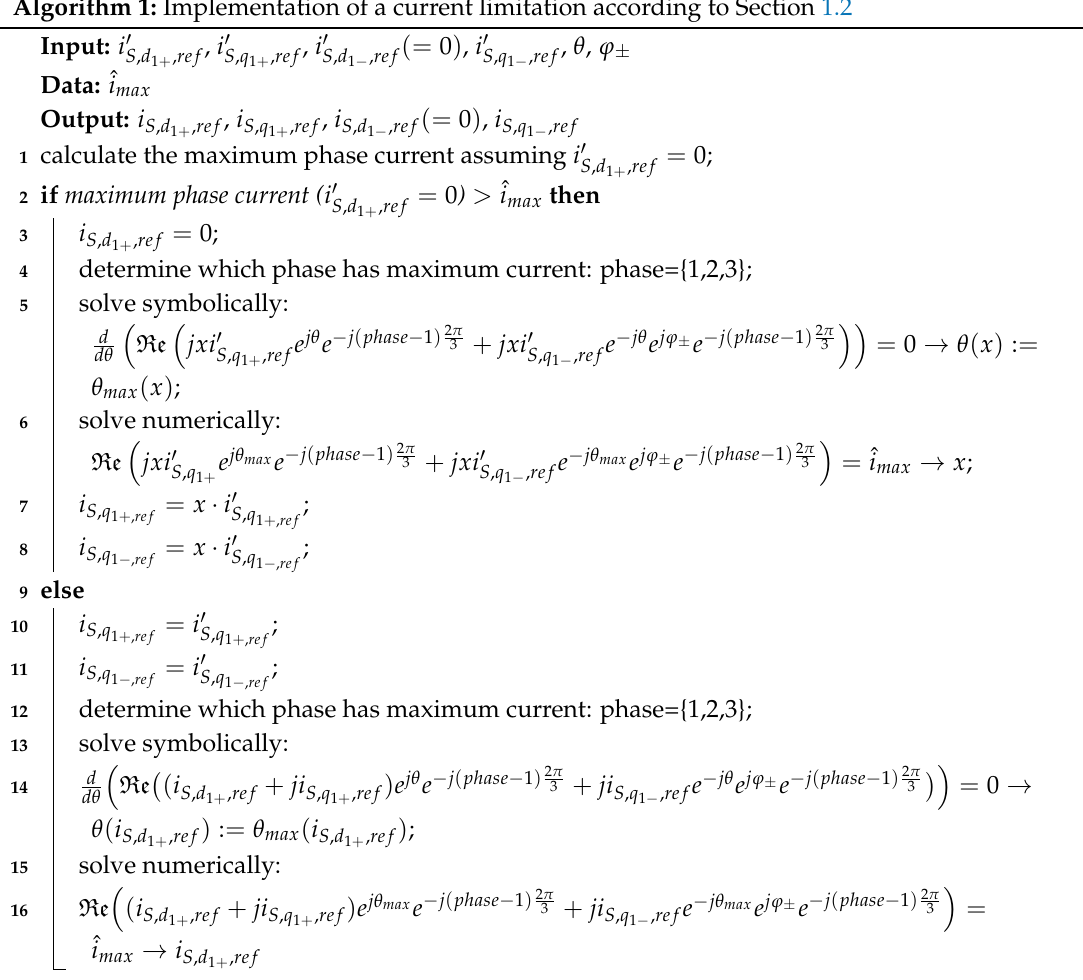
Algorithm 1: Implementation of a current limitation according to Section